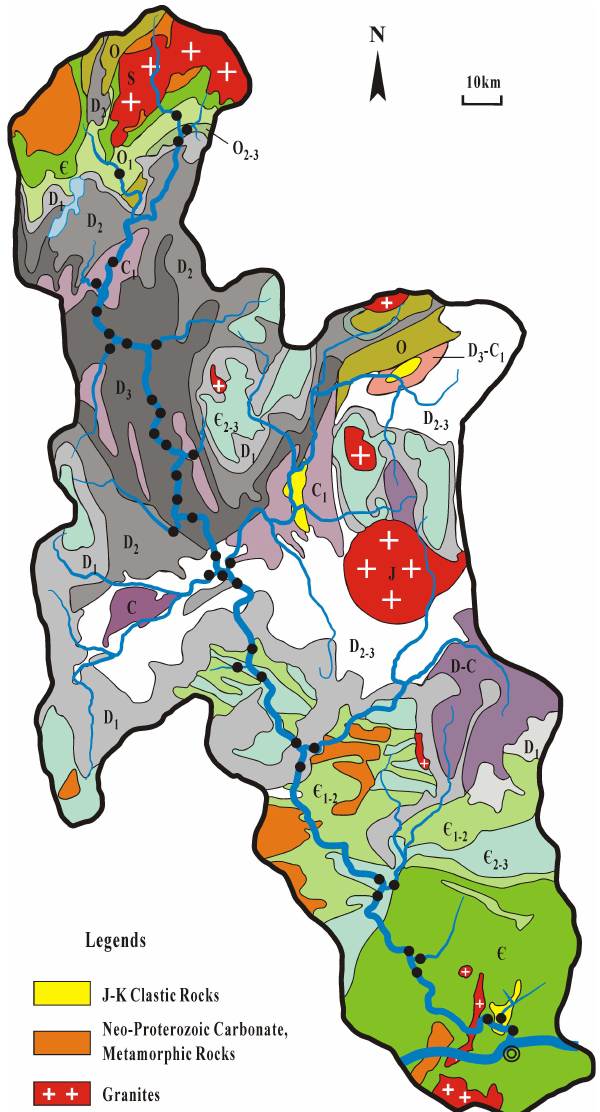
Fig. 4. Geological map of the Guijiang River catchment (modi- fied from the China Geological Survey, 2004). (cid:15) : Cambrian mixed layer; (cid:15) 1 − 2 : limestones/dolomites intercalated shales; (cid:15) 2 − 3 : lime- stones intercalated shales; O : Ordovician mixed layer; O 1 : shales, mud rocks, limestones, and dolomites; D 1 : sand rocks, mud rocks, and a few carbonate rocks; D 2 : carbonate rocks and detrital rocks; D 2 − 3 : carbonate rocks, sand rocks, and mud rocks; D 3 : carbonate rocks; D 3 – C 1 : detrital rocks, carbonate rocks, and mud rocks; D – C : Devonian–Carboniferous mixed layer; C : Carboniferous mixed layer; C 1 : carbonate rocks, sand rocks, and mud rocks intercalated